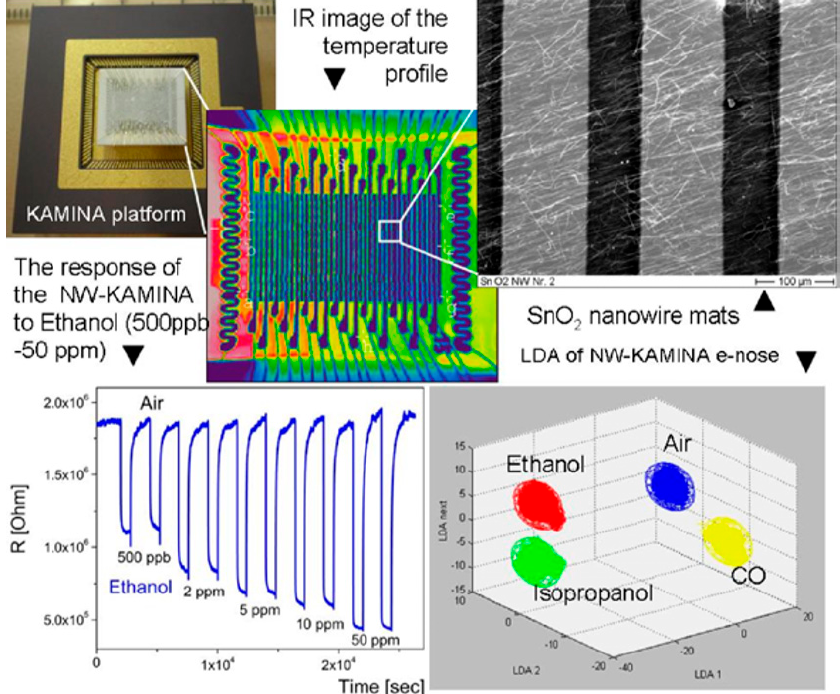
Figure 10. A demonstration of the KAMINA e-nose system performance with SnO 2 nanowires as a sensing media. Reproduced with permission from Sysoev et al. [213]. Copyright 2007: American Chemical Society.